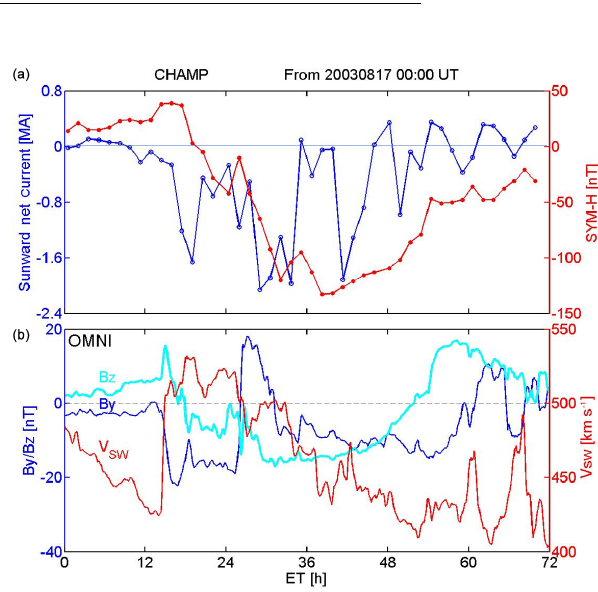
Table 1. The E m dependence of the net eastward currents during the June and December solstice months for both the dawnside and duskside. Season Local time sector Northern Hemis. Southern Hemis. Slope Inters. Slope Inters. (10 6 AmV − 1 ) (kA) (10 6 AmV − 1 ) (kA) Months: May–Aug Dawn − 78 83 − 75 44 Dusk 49 Months: Nov–Feb Dawn Dusk